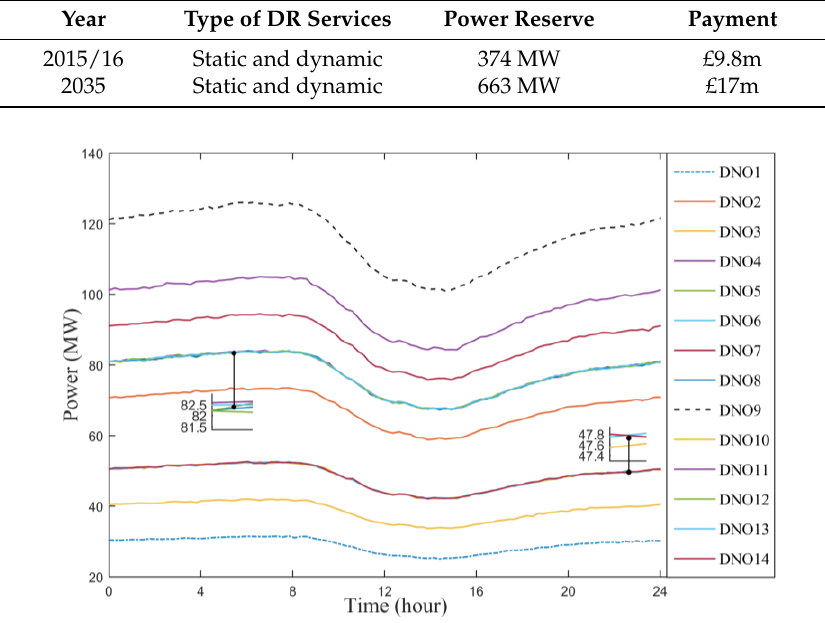
Figure 4. A predicted overall demand of the DHPs for each DNO area by 2035.